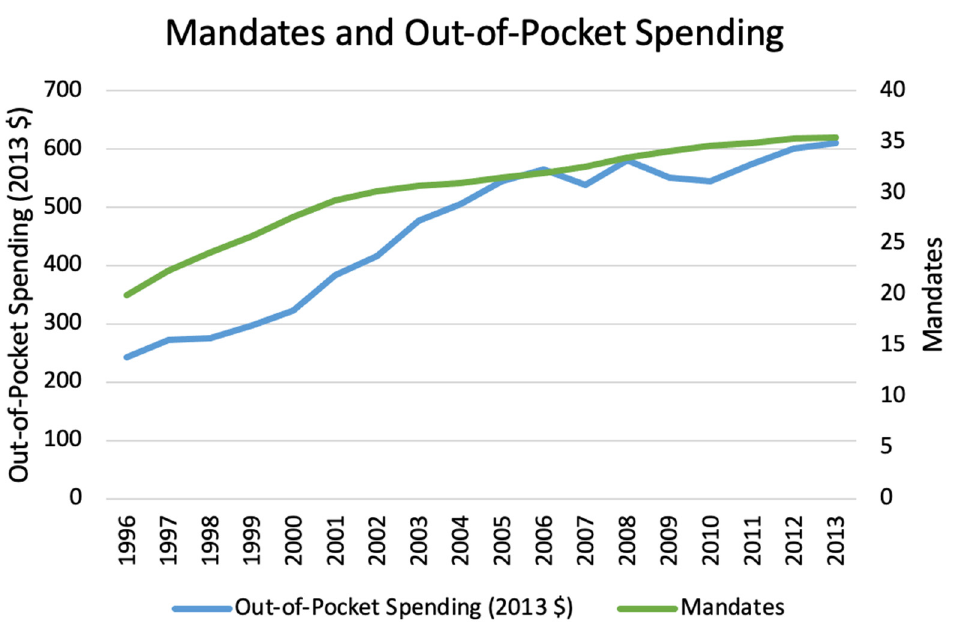
Figure 1. Mandates and out-of-pocket spending. Source: author calculations using mandate data from Laudicina et al. (2013) and spending data from the public version of MEPS-HC.